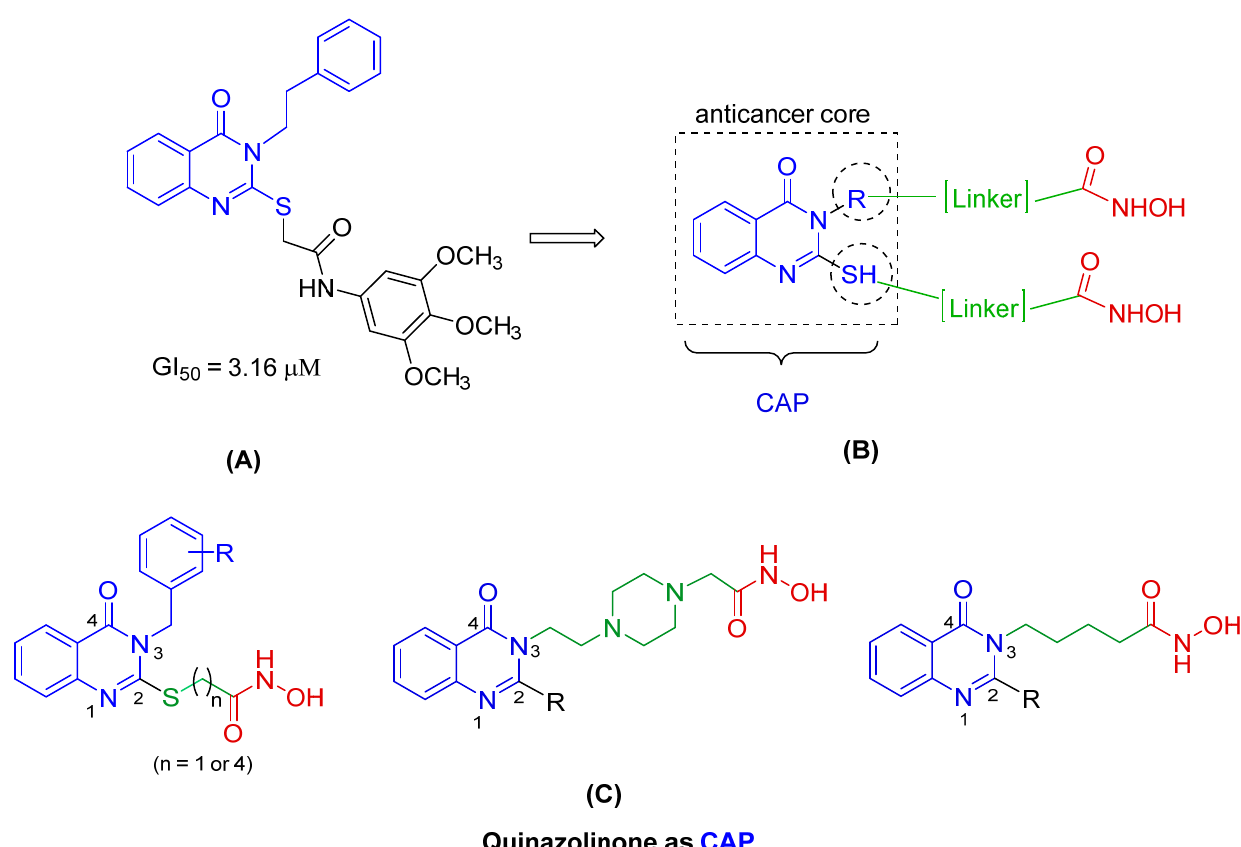
Figure 2. ( A ) Structure of 2-mercaptoquinazoline as the antitumour activity; ( B ) rational design tem- plate for quinazolinone hydroxamate conjugates; and ( C ) general structures of the target com- pounds.